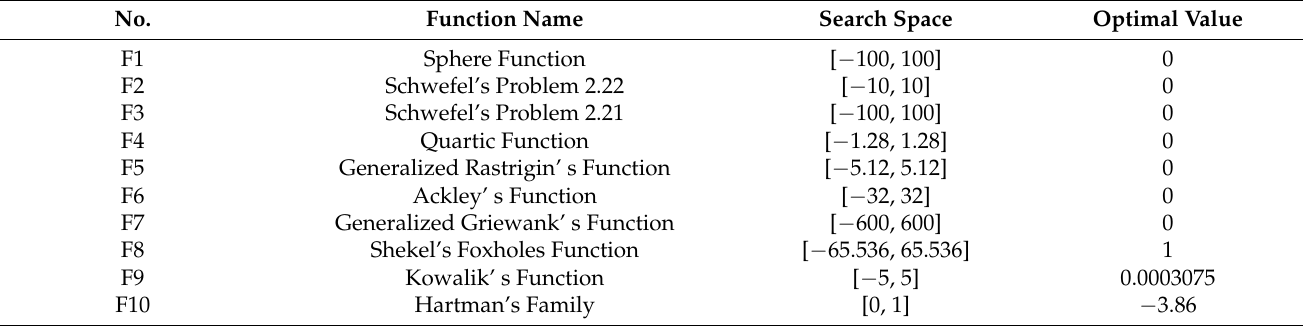
Table 5. Benchmark test functions.